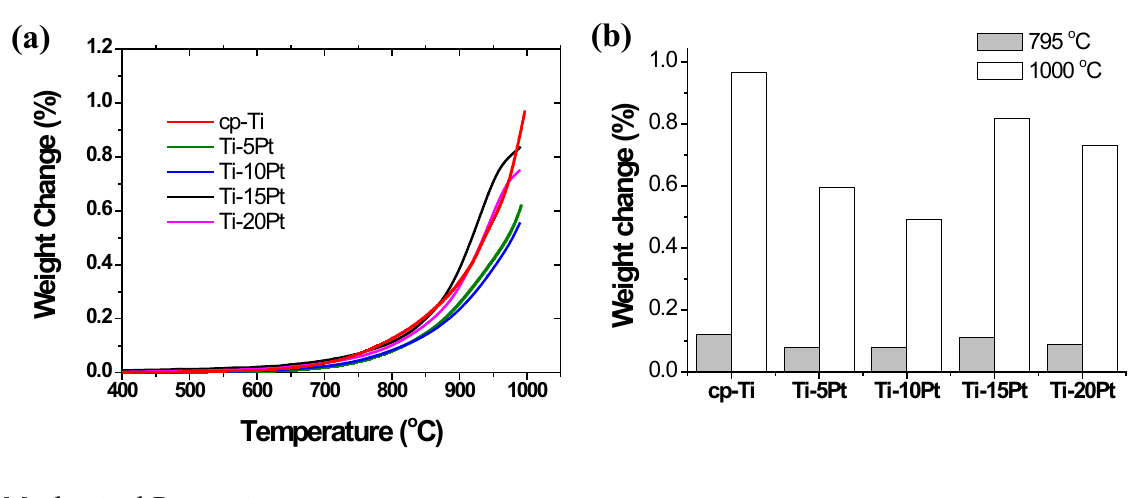
Figure 4. Thermogravimetric analysis (TGA) of cp-Ti and Ti-xPt alloys showing various degrees of weight gain (%) after heating in air. ( a ) TGA curves showing a single parabolic increment in mass; ( b ) various degrees of weight gain (relative wt%) by heating in air up to 795 °C and 1000 °C.